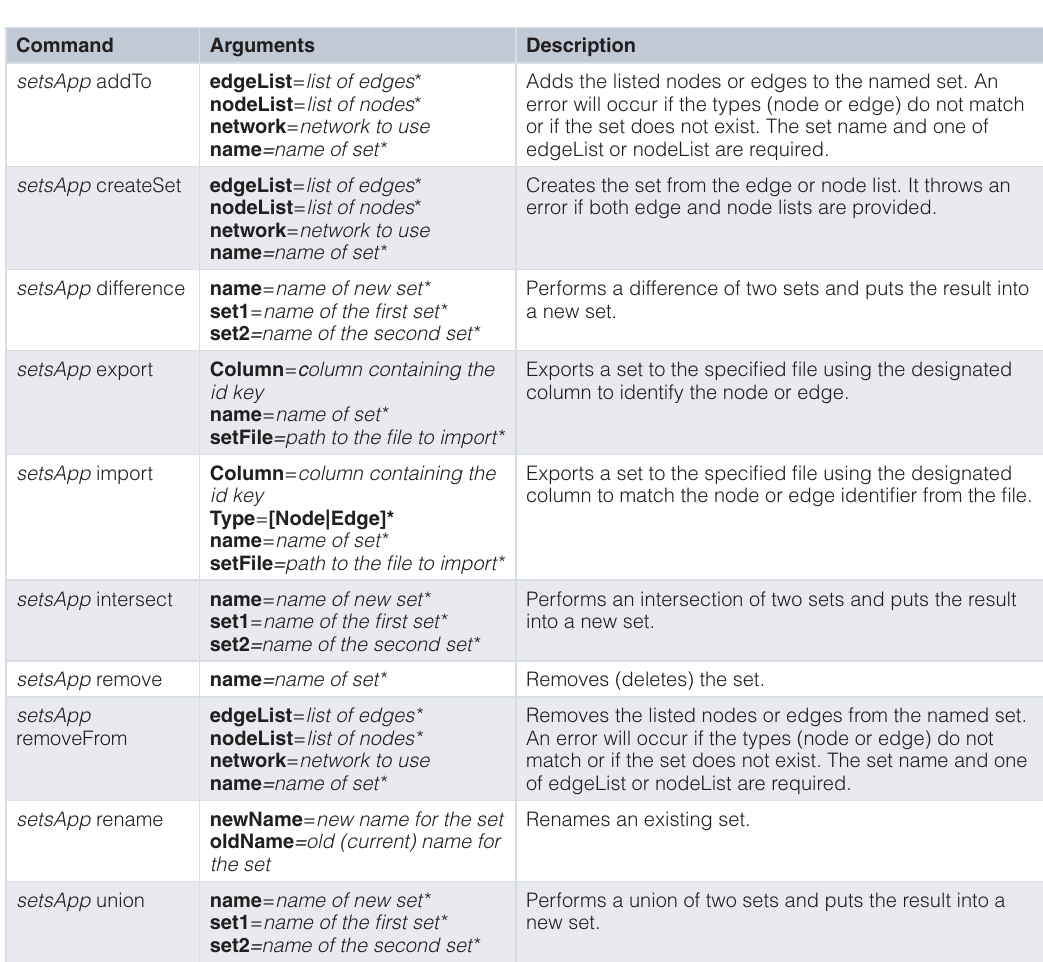
Table 1. setsApp Commands. Arguments with asterisks are